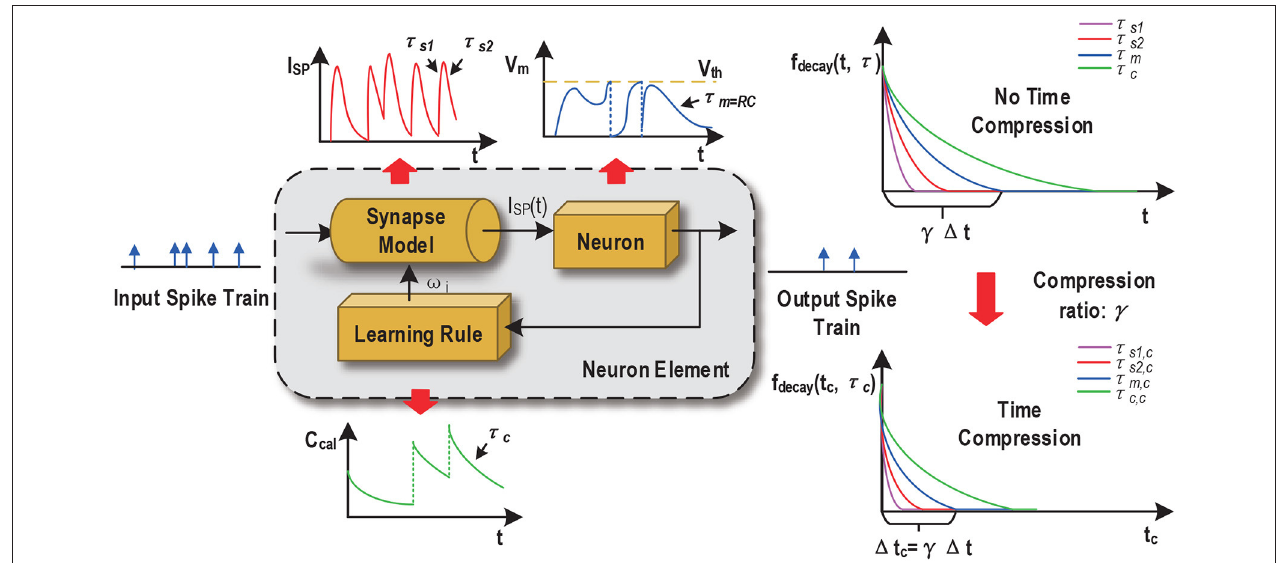
FIGURE 4 | Scaling of time constants of SNN